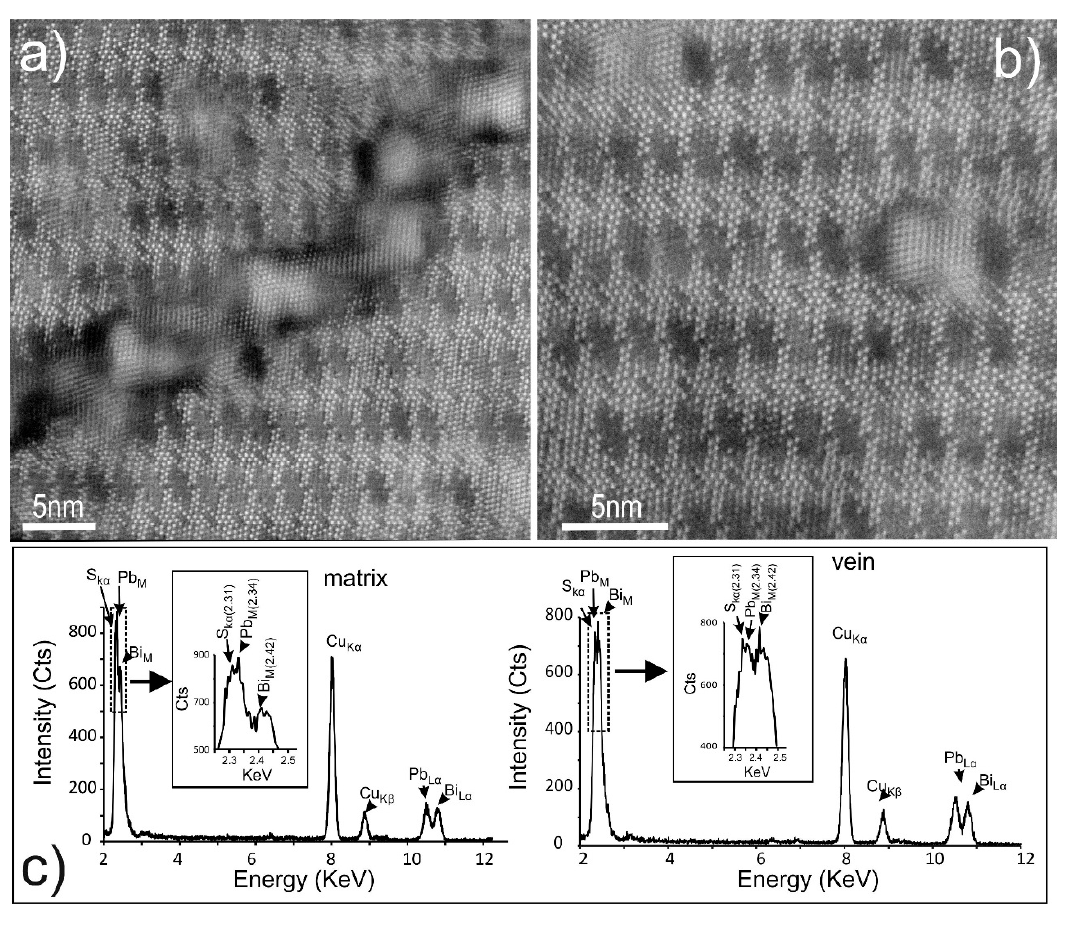
Figure 13. HAADF STEM images ( a , b ) and EDS spectra ( c ) showing the replacement of neyite (Pb-Bi-sulphosalt B) by aikinite in area (ii) of foil 2 (Figure 6h). Neyite is tilted down to the [010] zone axis; aikinite shows lattice fringes down to [11-1] zone axis—see Figure 14b. ( a ) Nanometre-sized vein of aikinite with a kink-like trajectory. Note the darker margins, as well as the protrusions within neyite; ( b ) Nanoparticles of aikinite (NPs) with typical 1–3 nm size, centred on the (111) PbS slabs in the neyite structure. Note that they have round shapes; ( c ) EDS spectra representing the matrix neyite and vein aikinite, showing the relative differences for the peaks of the main elements (Bi and Pb). The high Cu peak is due to interference from the Cu grid. Note that the Ag peak is not visible for neyite (concentration threshold for the detector?).